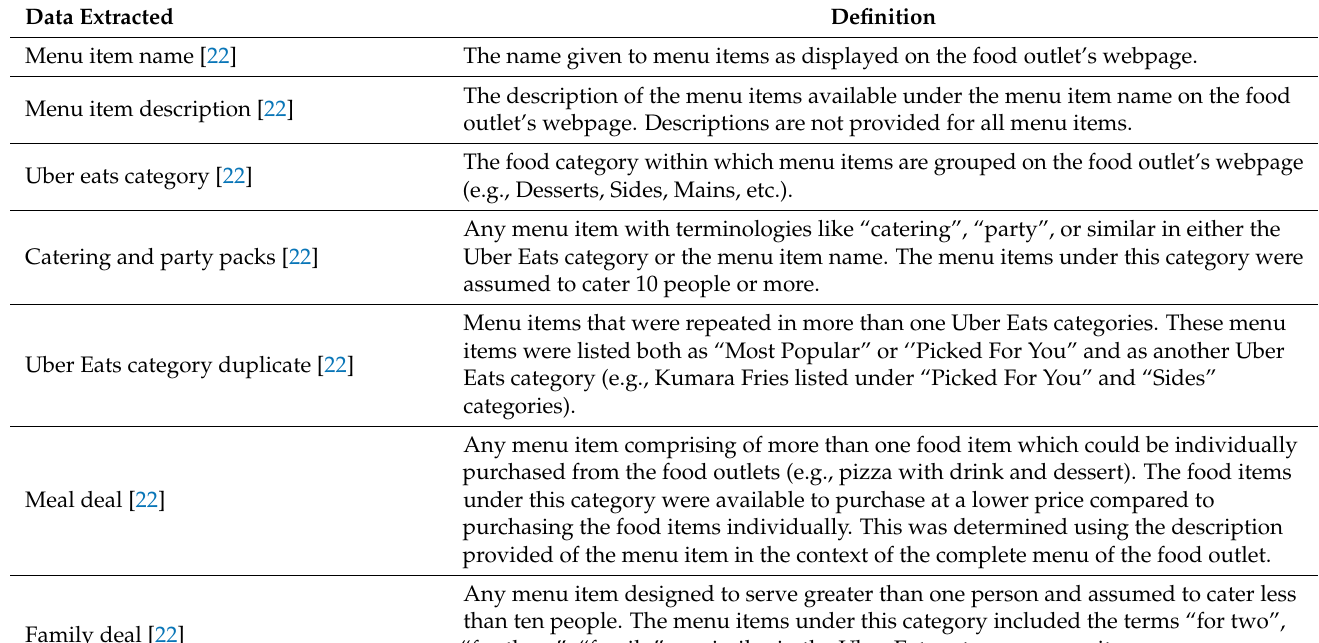
Table 1. Summary of definitions and derivations of data extracted from complete menus of each independent and franchise food outlet on Uber Eats and study